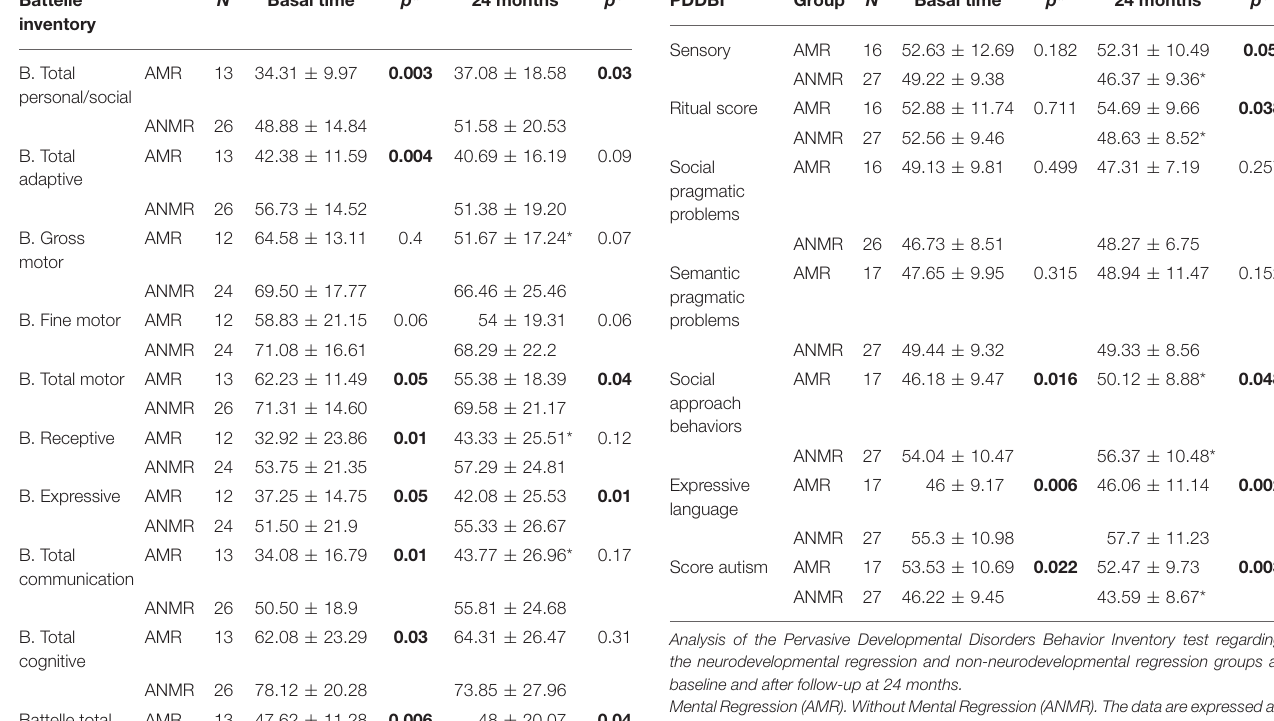
TABLE 4 | Analysis of the Pervasive Developmental Disorders Behavior Inventory test in the ASD subgroups with and without neurodevelopmental regression at baseline and at a follow-up at 24 months.